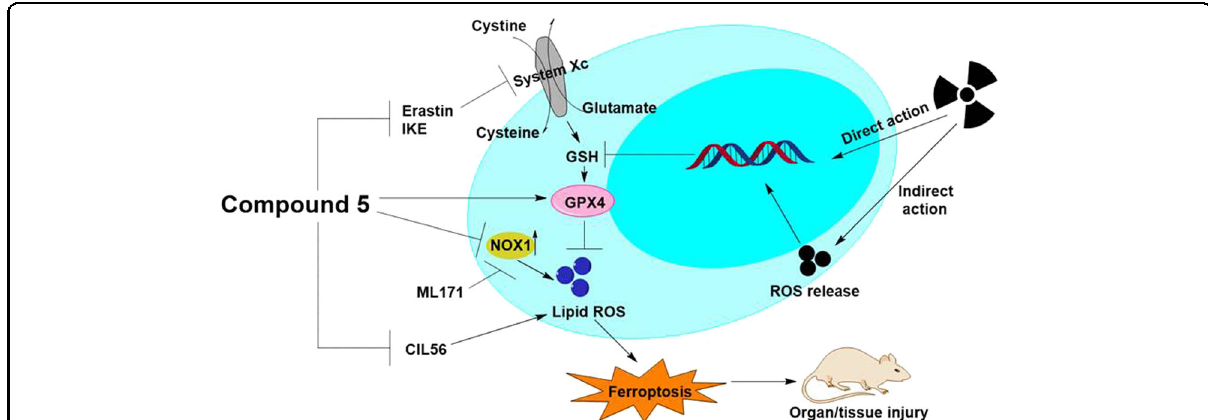
Fig. 9 A scheme shows the radiation protective mechanism of compound 5. Ionizing radiation (IR) causes DNA double-strand breaks and oxidative damage through direct/indirect action, induces the decrease of the intracellular GSH level and down-regulation of GPX4 expression,